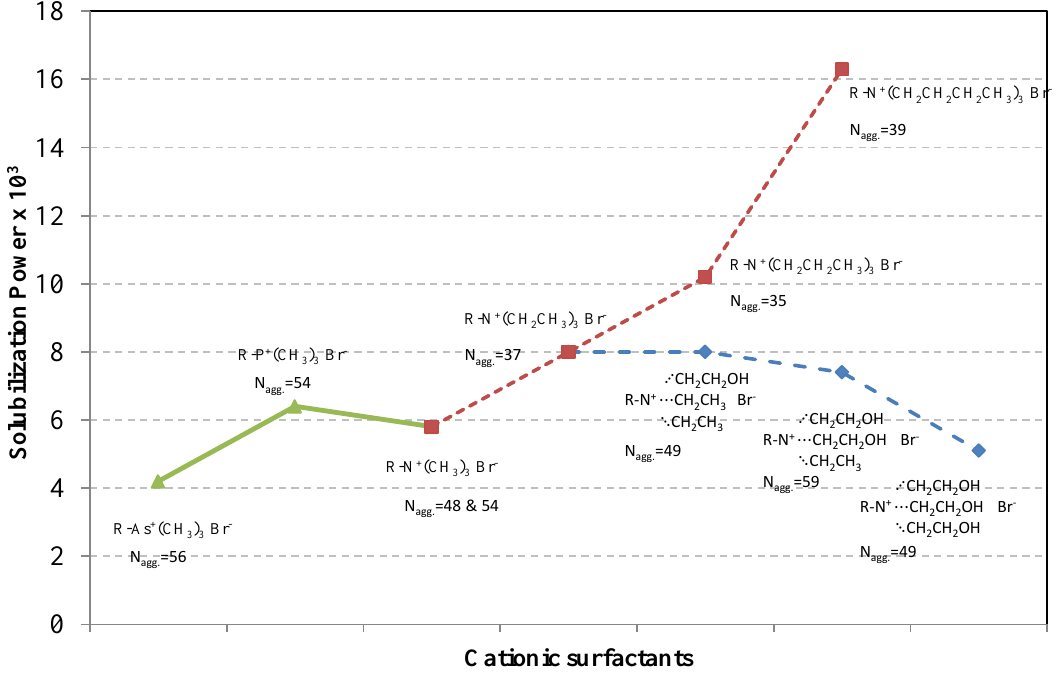
Figure 9. Effect of polar head group on molar solubilization power at 25 °C of the dye C.I. Solvent Orange 2 (Orange OT) by different cationic surfactants, all based on a decyl chain as hydrophobic tail and all having bromide as counterion. The aggregation numbers (N are also given for each surfactant. Data from